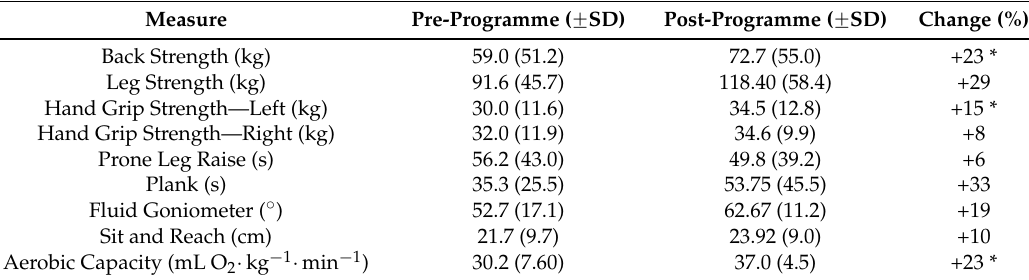
Table 4. Pre-post programme physiological performance data.